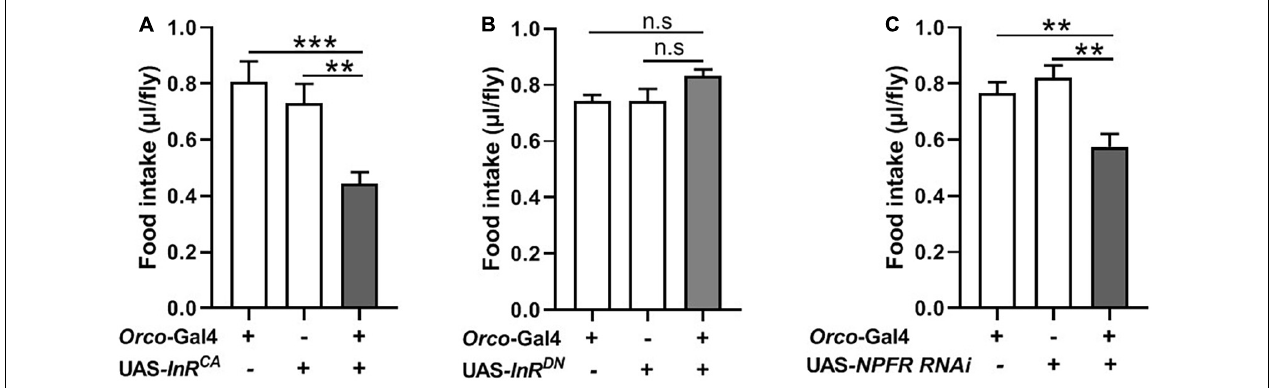
FIGURE 5 | Modulating expression of InR and NPFR in OSNs affect food intake. (A) Increasing InR activity in OSNs by driving a UAS- InR CA decreased food consumption ( n = 20). (B) No effect on food intake after decreasing InR activity ( n = 12). (C) Decreasing NPFR expression in OSNs inhibited food intake ( n = 18). One-way ANOVA followed by Dunnett’s post-hoc test were used to analyze the difference. ** p < 0.01 and *** p < 0.001.